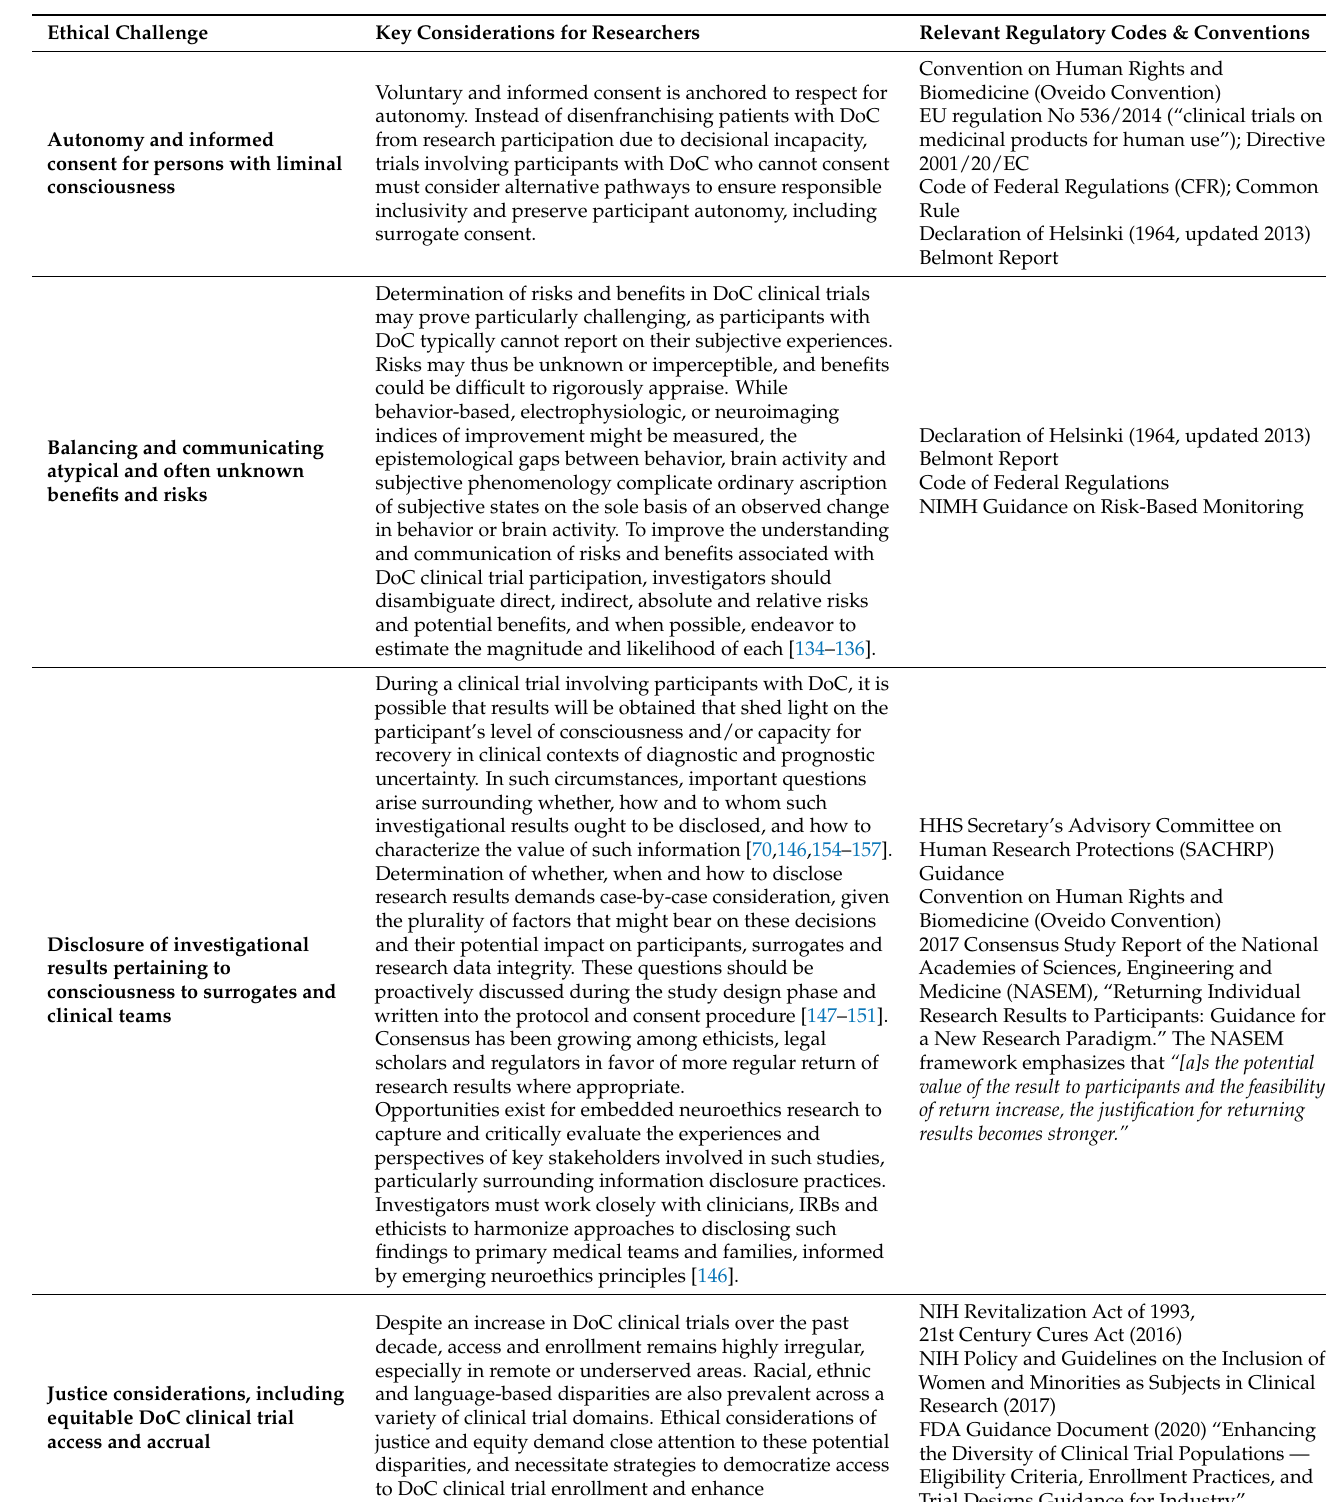
Table 1. DoC Clinical Trials: Salient Ethical Challenges, Considerations for Researchers & Selected Regulatory